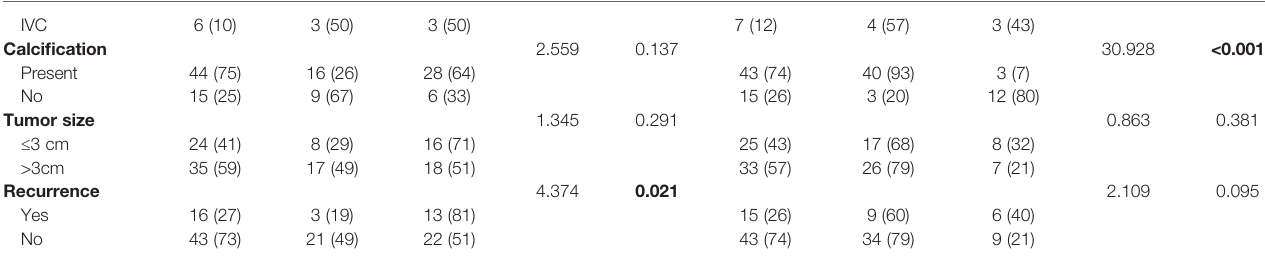
The statistically signi fi cant fi nding was highlighted with bold. IVC, intraventricular craniopharyngioma; S/SSC, sellar/suprasellar craniopharyngioma; IS, immunostaining score; L.I., labeling